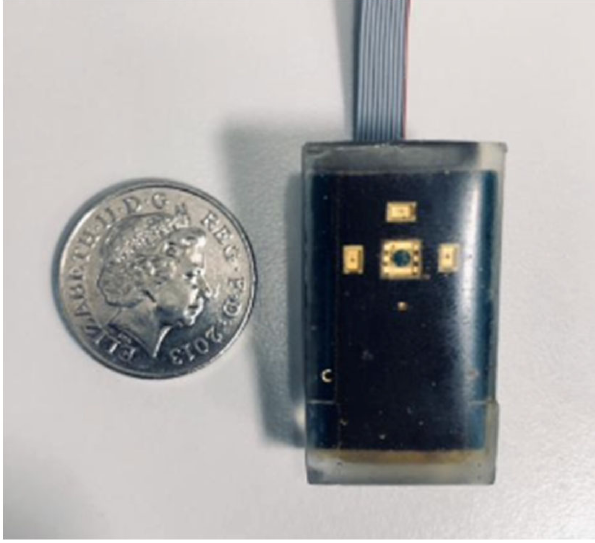
Figure 5. Developed prototype for optical sensor, consisting of four LED wavelengths and one photodiode [27].